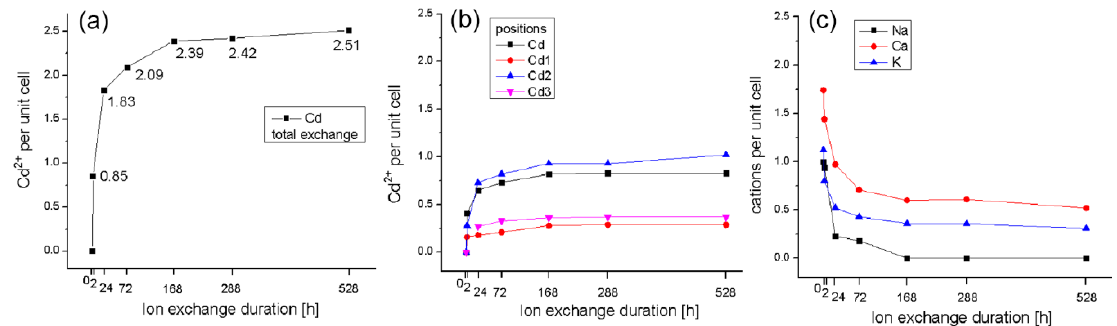
Figure 8. Extent of Cd exchange ( a ), Cd sites ( b ) and outgoing cations ( c ) at 90 °C.